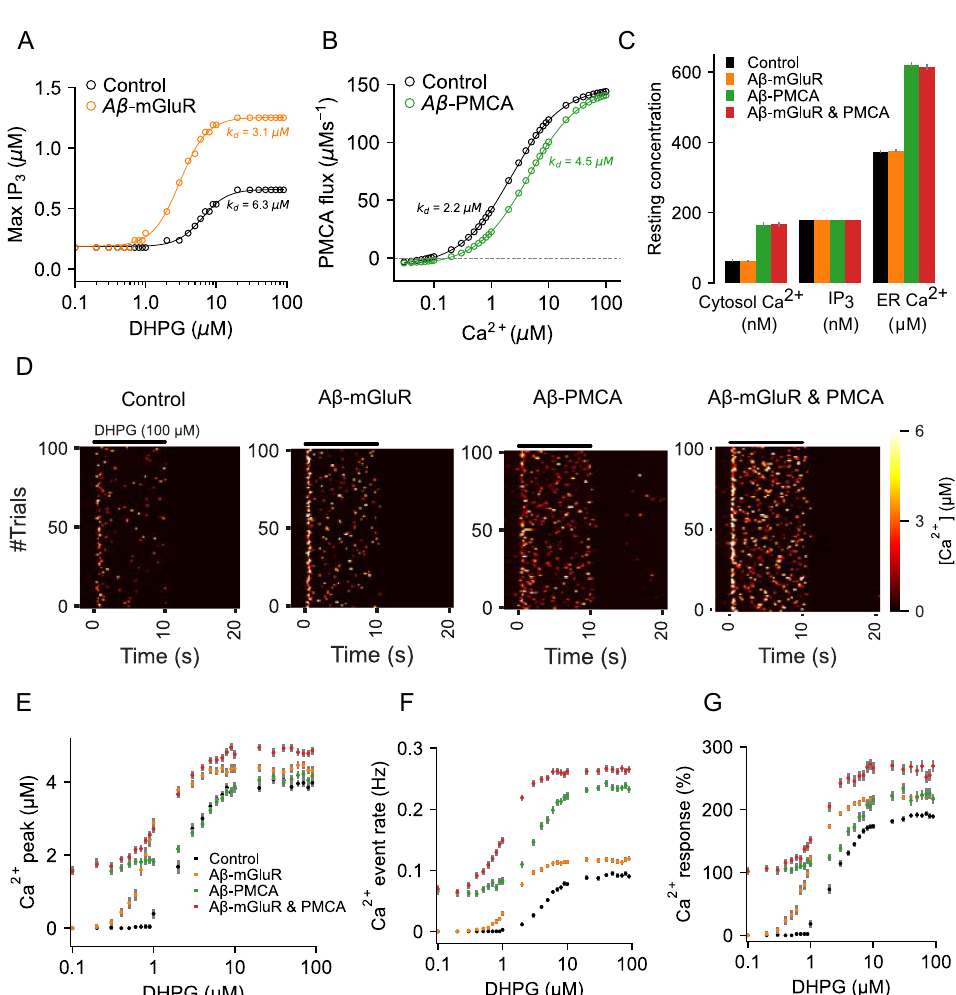
Fig 4. Characterization of the astrocytic compartmental models with A β -induced molecular alterations. (A) Peak amplitudes of IP 3 generated by DHPG stimulation from control and an astrocytic compartment with altered mGluR function are fitted to Hill functions for estimating dissociation constants ( k ). (B) Steady-state PMCA fluxes from d control and A β -PMCA conditions fitted to Hill functions. (C) Resting cytosolic Ca 2+ , IP 3 , and ER Ca 2+ levels in control and A β -conditions. (D) Representative heat maps of Ca 2+ signaling from control and A β conditions stimulated with DHPG. (E) Peak amplitude of Ca 2+ event evoked with different DHPG concentrations. (F) Rate of Ca 2+ events evoked by different DHPG concentrations. (G) Percentage Ca 2+ response evoked by DHPG stimulation is higher the presence of A β conditions. Error bars indicate the standard error of the mean computed from 6 independent sets of simulation trials.